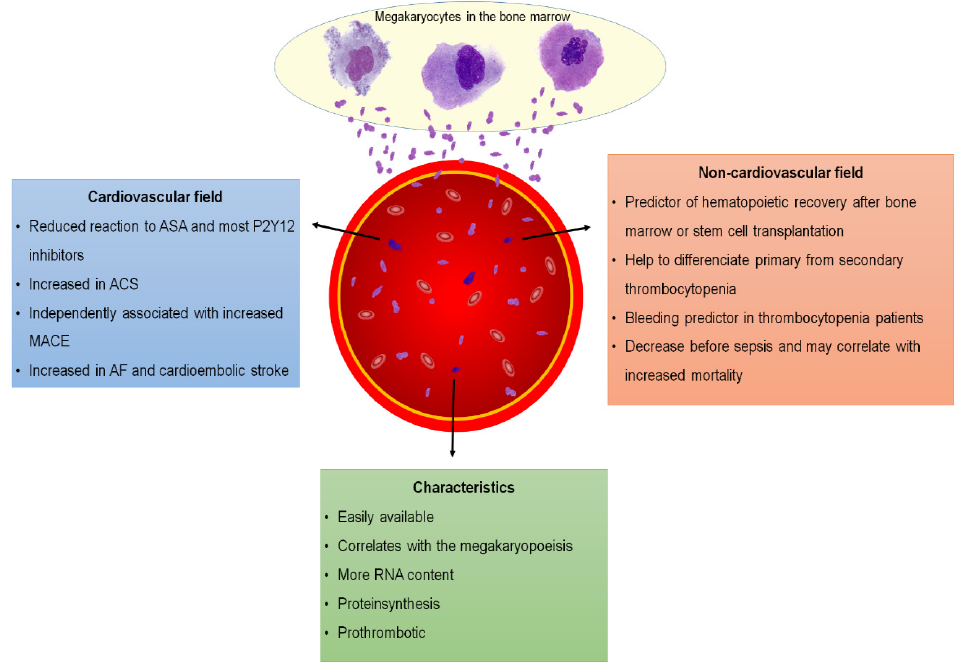
Figure 1. Characteristics of immature platelets and their clinical significance. ACS = acute coronary syndrome; AF = atrial fibrillation; ASA = acetylsalicylic acid; RNA = ribonucleic acid.